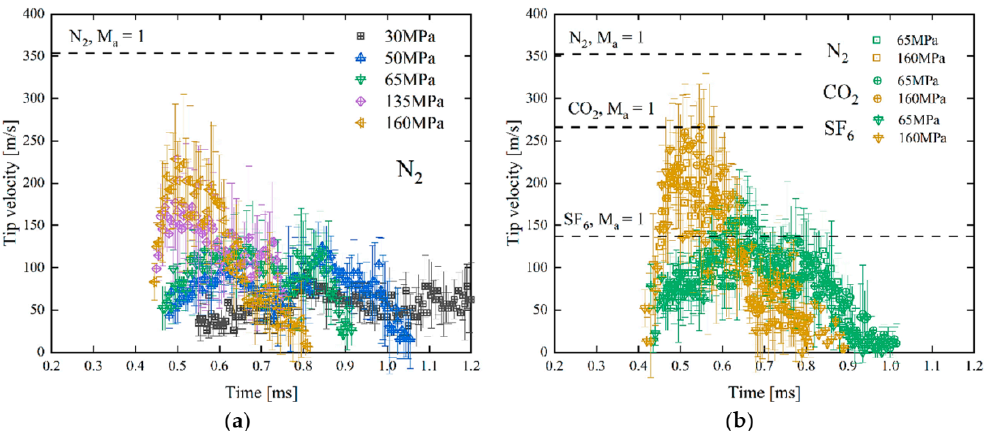
Figure 8. Spray tip velocities under di ff erent injection pressures: ( a ) spray tip velocities at various injection pressures; ( b ) spray tip velocities against various ambient gases. (Ambient gas condition: 297 K and 9.0 kg / m 3 ; Local sound speed: 352 m / s at N 2 ; 267 m / s at CO 2 ; 135 m / s at SF 6